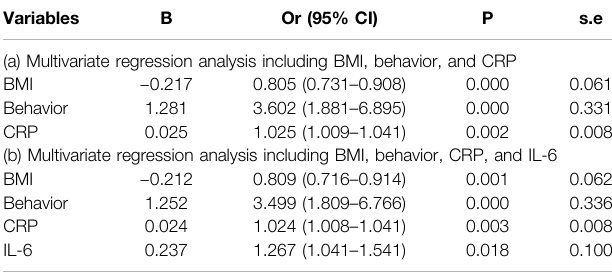
TABLE 1 | Multivariate regression analyses of the model 1 and model 2. Variables